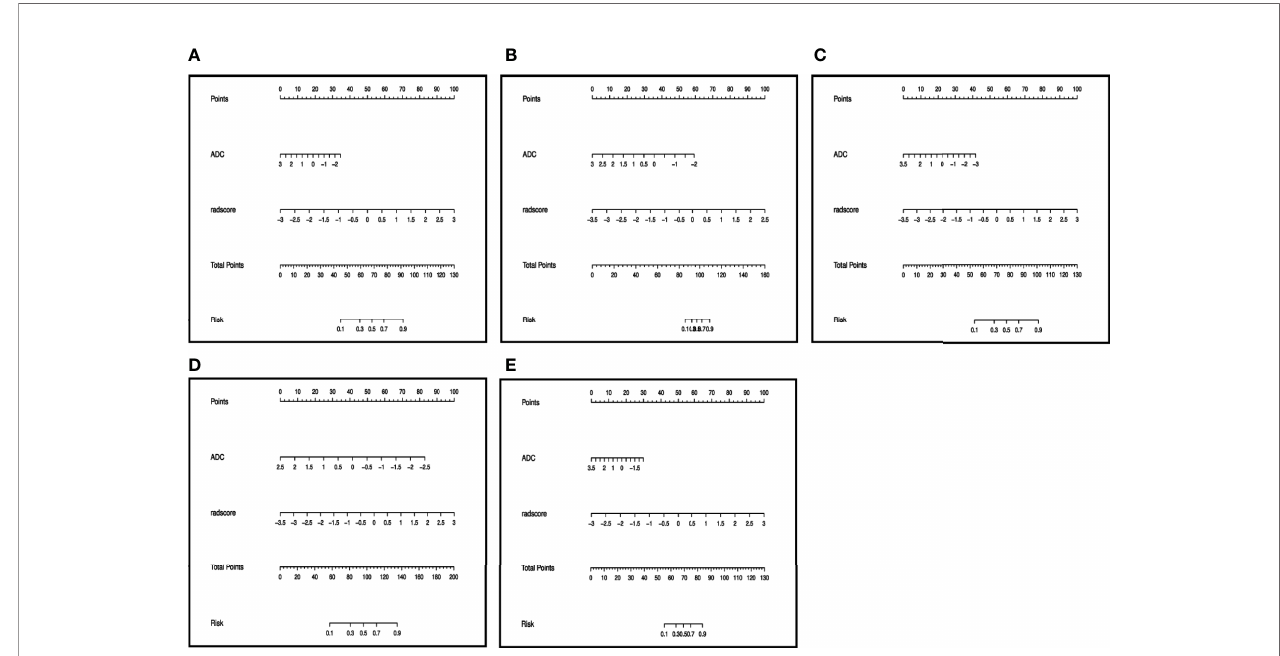
FIGURE 4 | Preoperative nomogram of the combined model for (A) type, (B) grade, (C) DMI, (D) LVSI, (E) LNM. The different value for ADC and radscore corresponds to a point on the line, total point is calculated by adding all the points up. And the fi nal predicted value was corresponded to the total point.